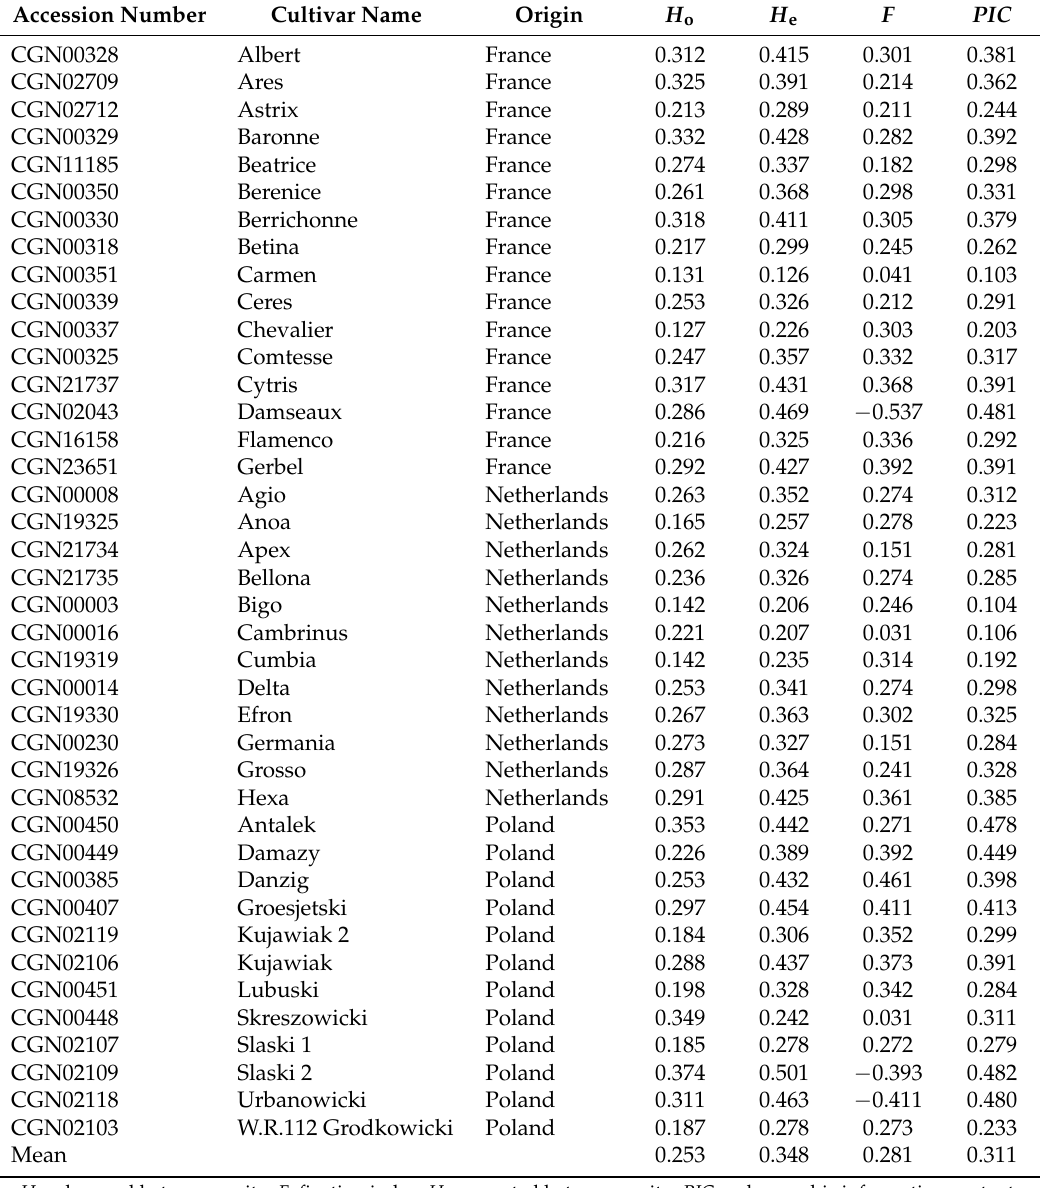
Table 2. Genetic variability indices of the 40 barley accessions